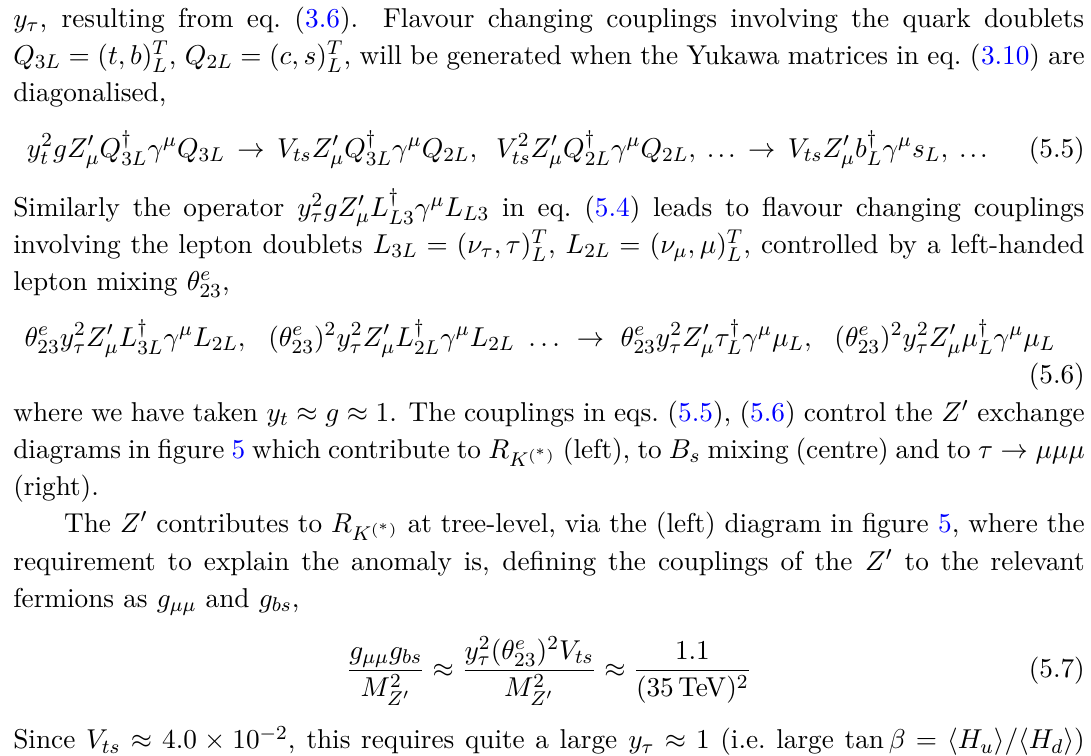
(left), to B s mixing (centre) and to K ( ∗ ) b † γ µ s L , g µµ Z 0 µ † γ µ µ L and g τµ Z 0 µ µ L L